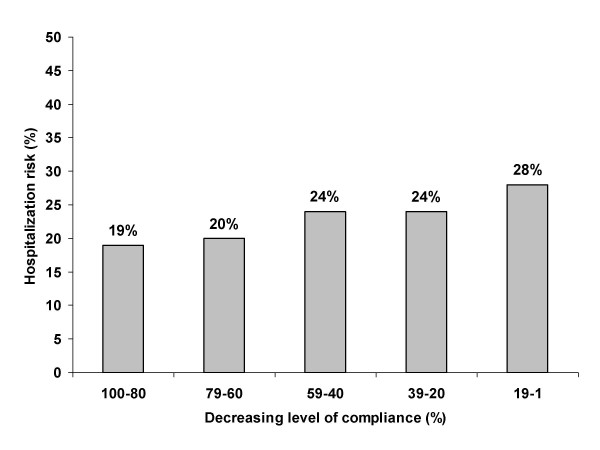
Risk of hospitalisation (%) in relation to the level of compliance for hypertension [24]. Level of compliance grouped into quintiles vs. risk of hospitalization. Patients with a high degree of compliance (of between 80 and 100%) have a 19% risk of hospitalization as compared to 28% in patients with a compliance between 1 and 19%.